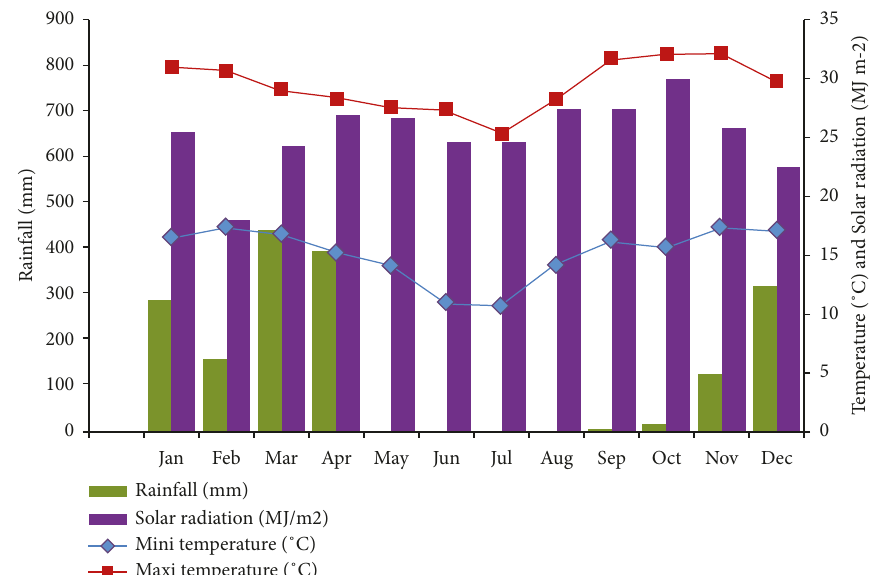
Figure 1: Mean monthly maximum and minimum temperature with total monthly rainfall for 2017–2018 and 2018–2019 seasons. The bar graphs show the total monthly rainfall and solar radiation, and the line graphs show the mean maximum and minimum temperatures. Table 1: Selected physicochemical properties of topsoil (0–30cm depth) of the experimental sites. Soil